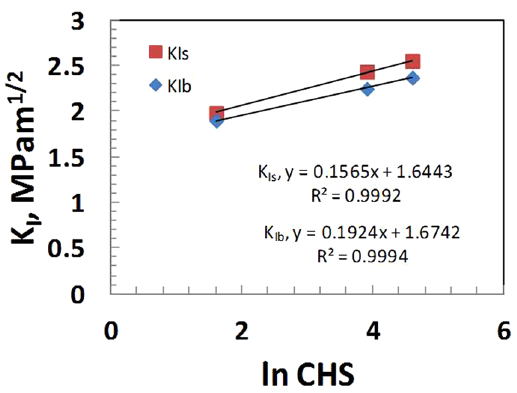
Figure 6. Plot of KIs as a function of ln CHS for sharp and blunt crack samples 45